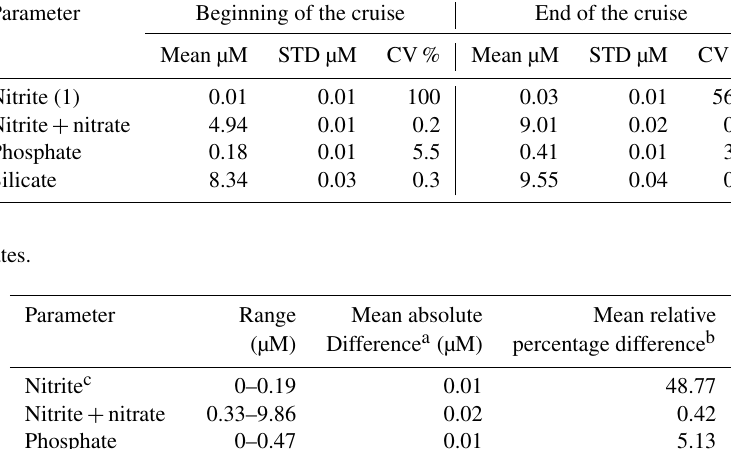
Table 7. On-board precision of nutrient measurements. Parameter